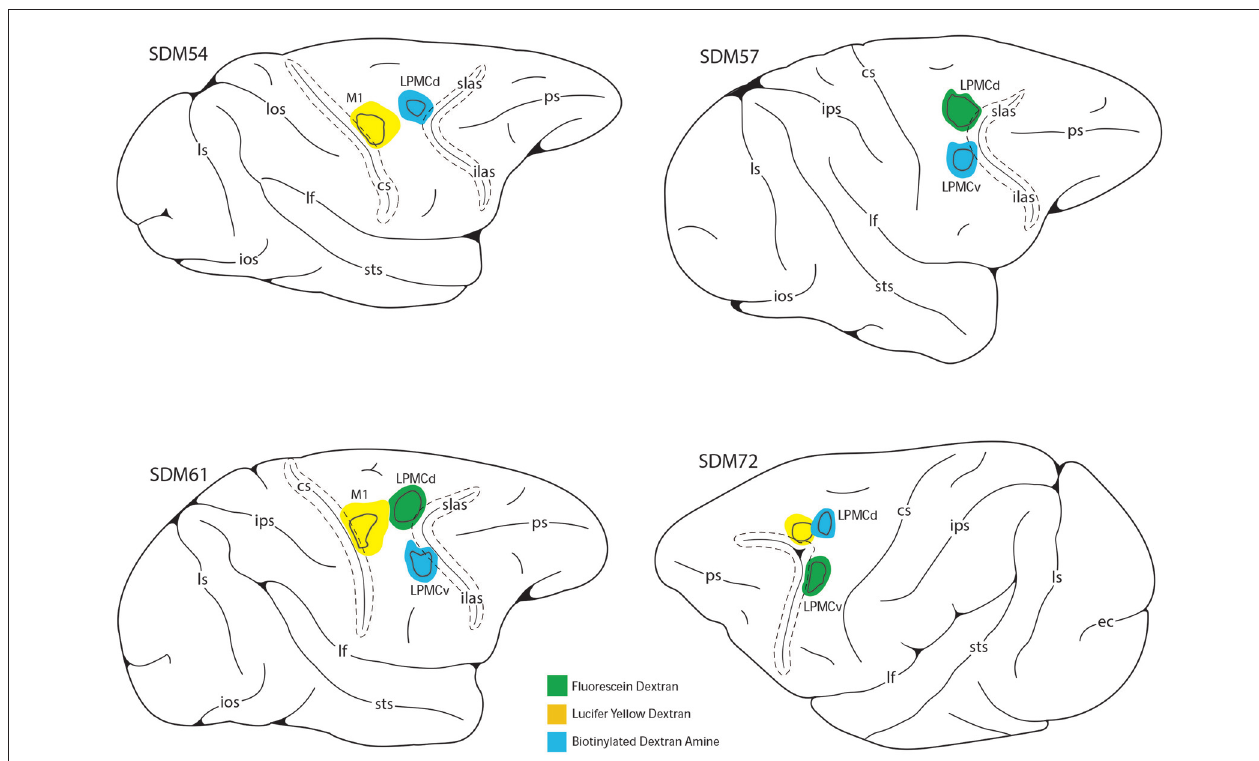
FIGURE 2 | Line drawings of the lateral surface of the cerebral cortex in cases SDM54, SDM57, SDM61 and SDM72 depicting the respective lucifer yellow dextran (LYD), fluorescein dextran (FD) and biotinylated dextran amine (BDA) injection sites into the cortical hand/arm region of M1, caudal part of LPMCd and dorsal part of LPMCv. On the color-coded injection sites, the irregular shaped black line within the injection site represents the boundary between the centrally located injection site core, and peripherally located injection site halo. All injection sites were localized using intracortical microstimulation (ICMS; Morecraft et al., 2007a,